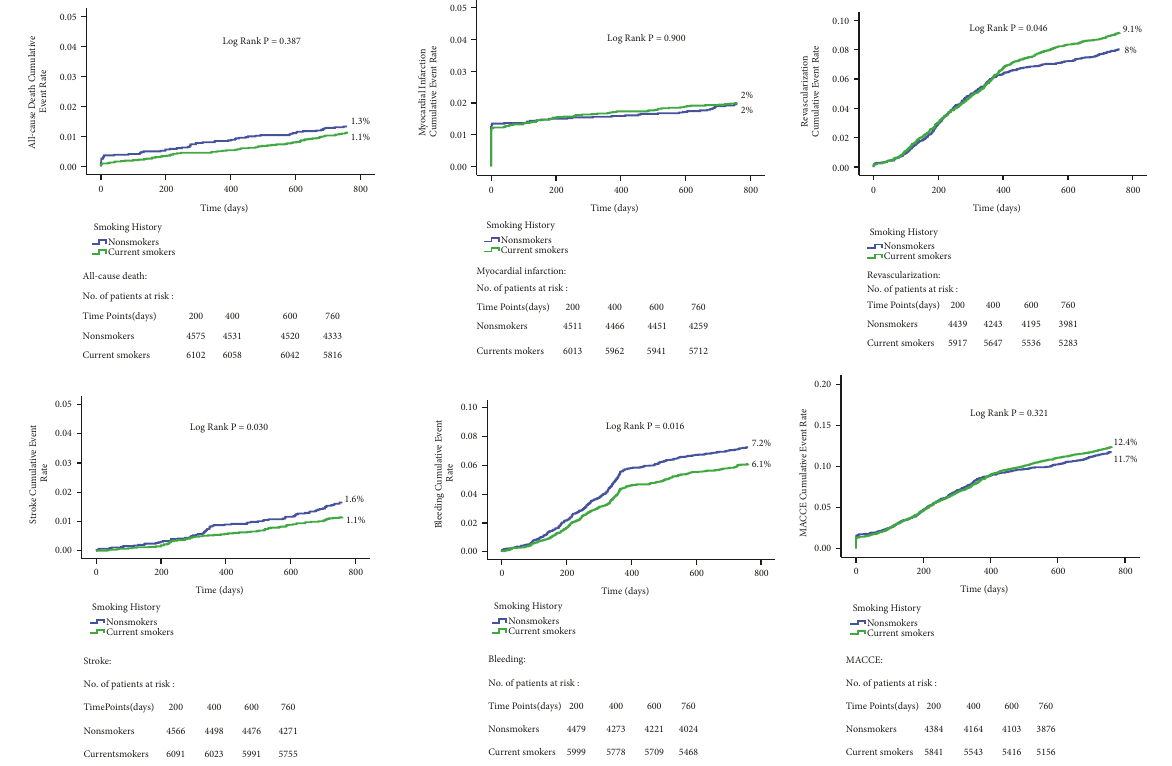
Figure 1: Kaplan-Meier survival curves between current smokers and